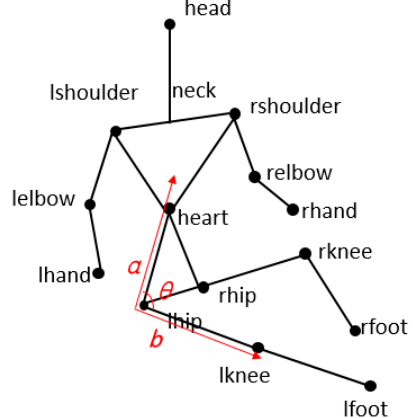
Figure 3. Posture angles of falling down.